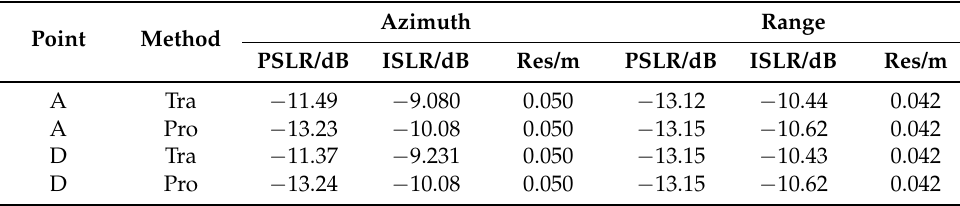
Figure 11. Azimuth upsampling envelope of point D in signal s 5 with different sub-aperture MoCo methods. Table 4. Point Target Analysis of Sub-Aperture MoCo with Signal s 5